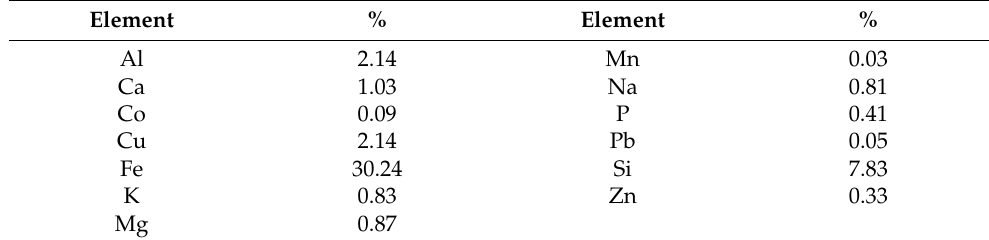
Table 1. Chemical composition of the ore.